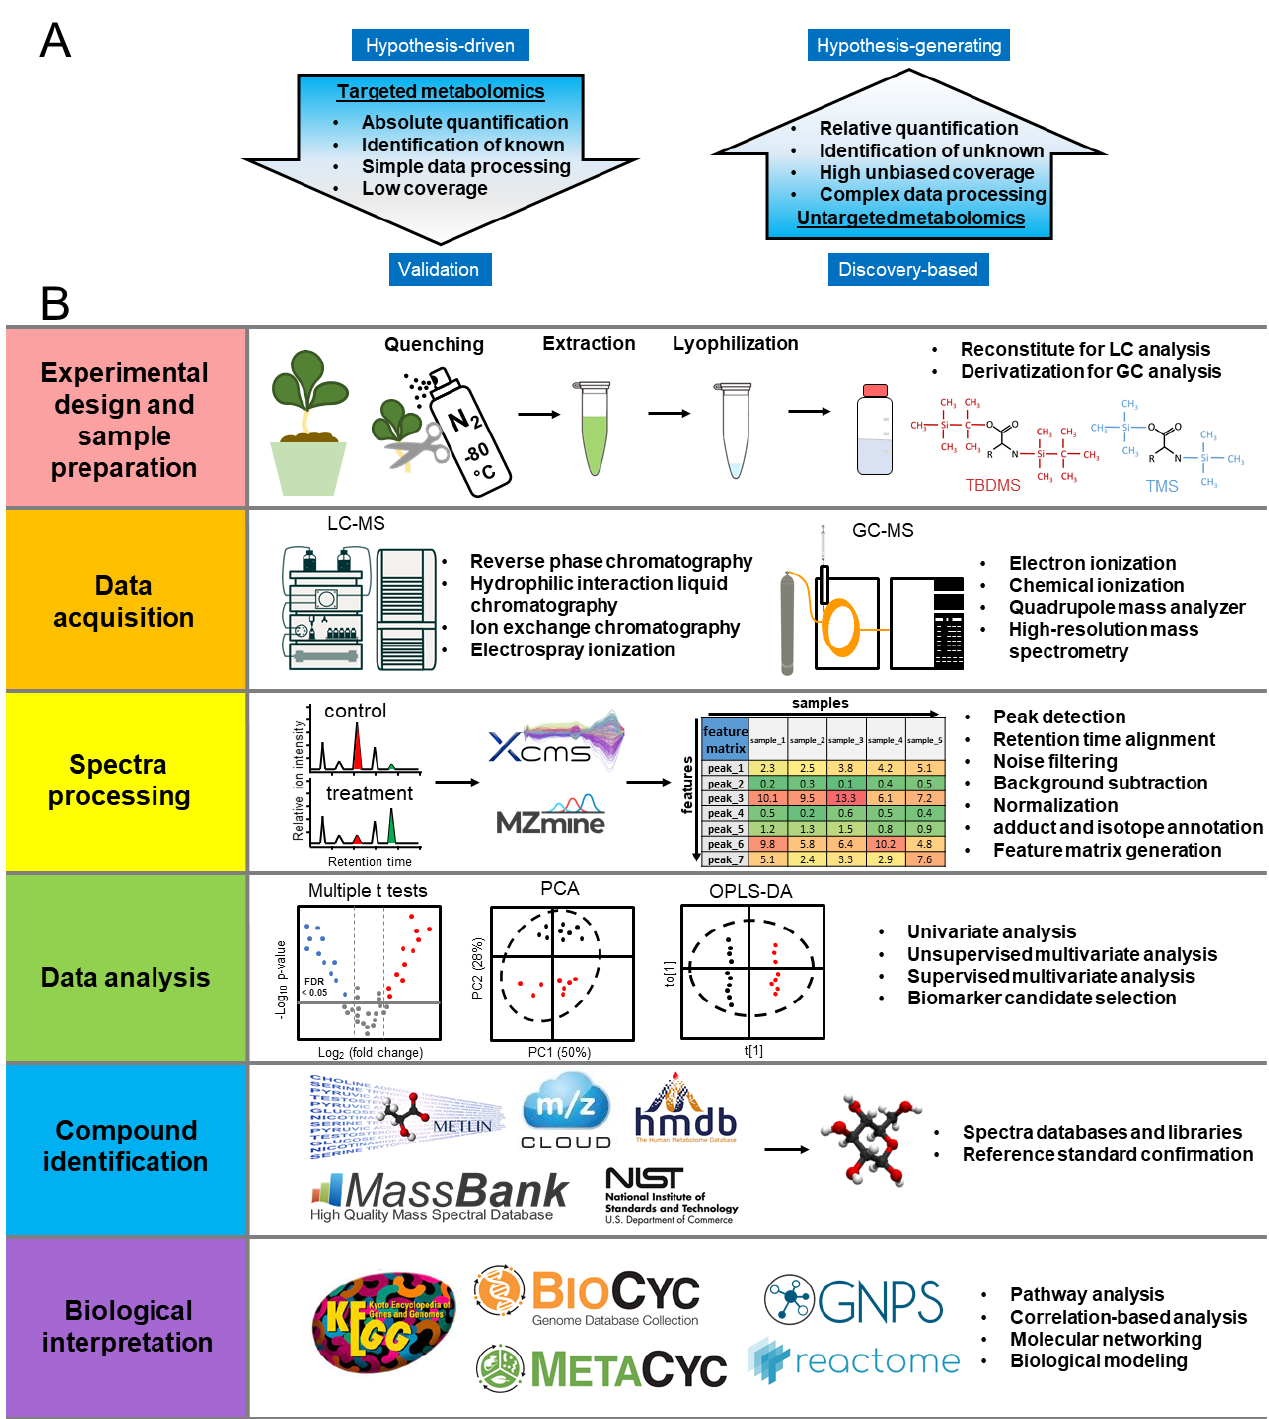
Figure 2. ( A ) Targeted and non-targeted metabolomics. ( B ) Protocol workflow of plant